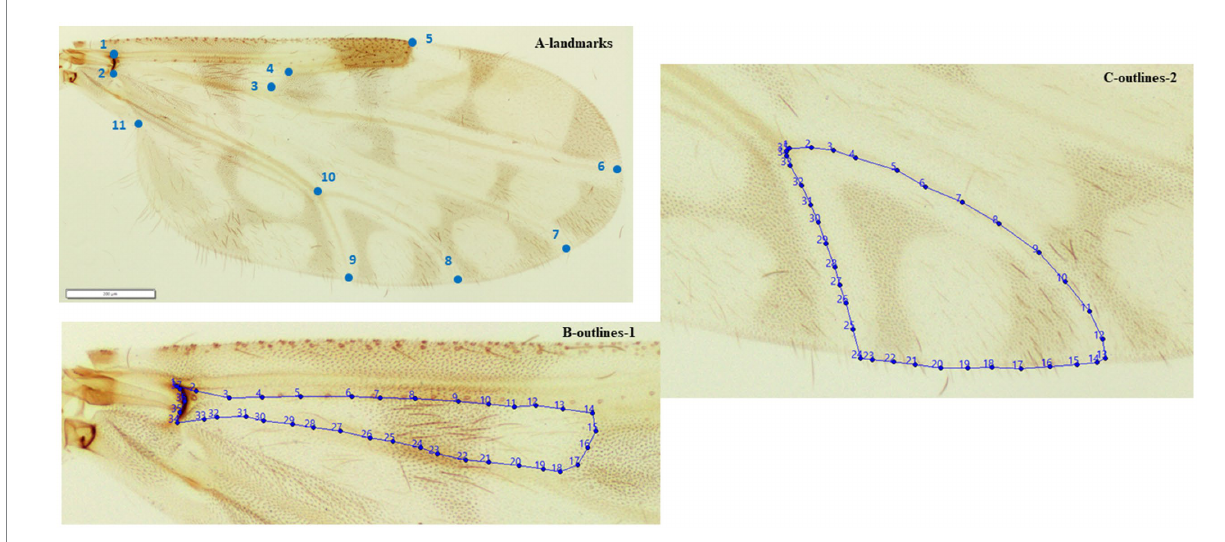
FIGURE 2 Position of the 11 landmarks (A) outlines-1 (B) outlines-2 (C) on the right wing of adult female Culicoides circumscriptus used for geometric morphometric